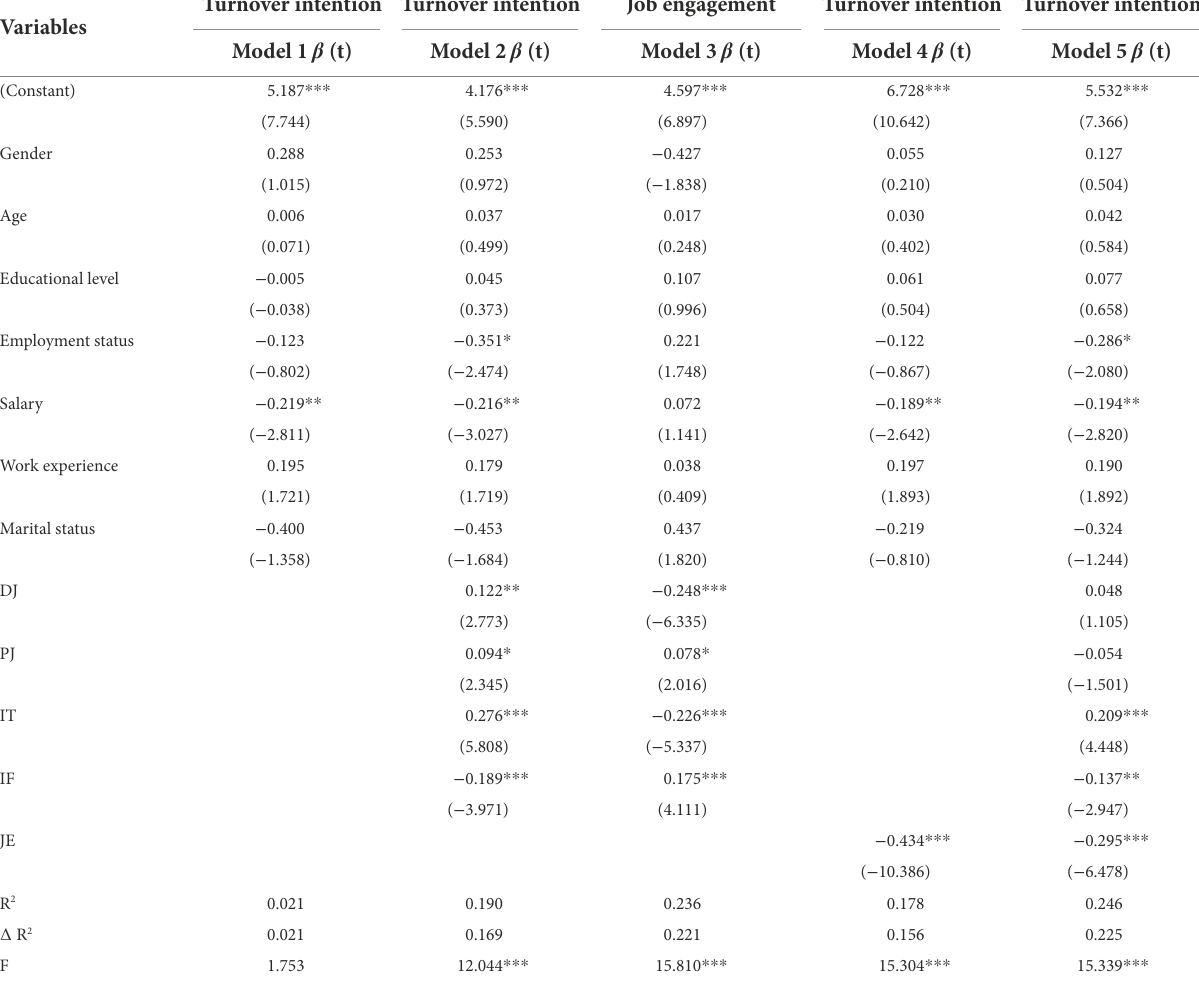
TABLE 4 Hierarchical regression analysis results of the main effect and the mediating effect of job engagement.